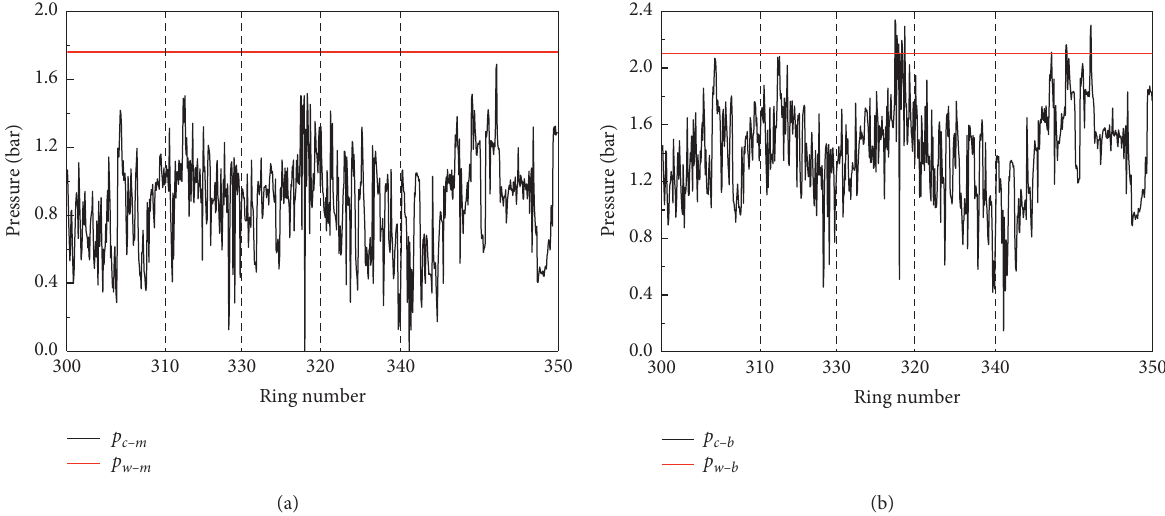
Figure 5: Chamber pressure of the shield and water pressure of excavation surface wheel at 300–350 rings. p of the pressure chamber, p w − m is the water pressure in the middle of the excavation surface, p c − b is the pressure at the bottom of the pressure chamber, and p w − m is the water pressure at the bottom of the excavation surface.